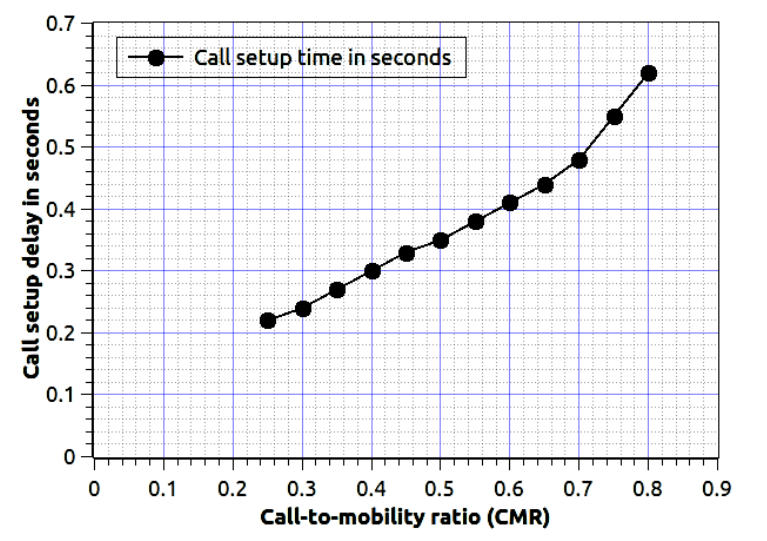
Figure 8. Call-to-mobility ratio verses call setup delay. We consider λ i and µ i = 0.001, n = 100, M = 1000 and node velocity = 50